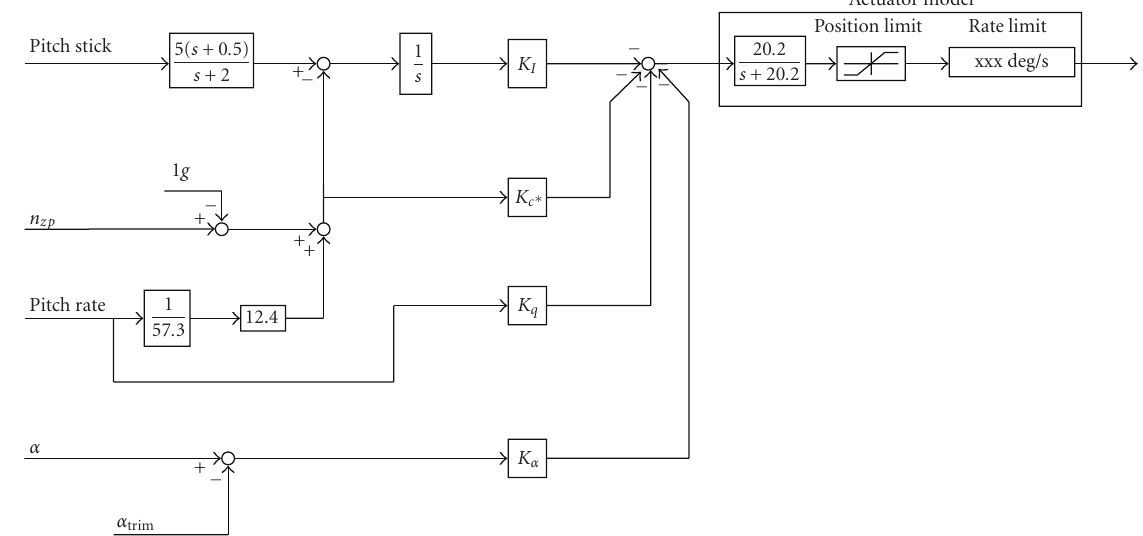
Figure 5: Block diagram of longitudinal flight control system.